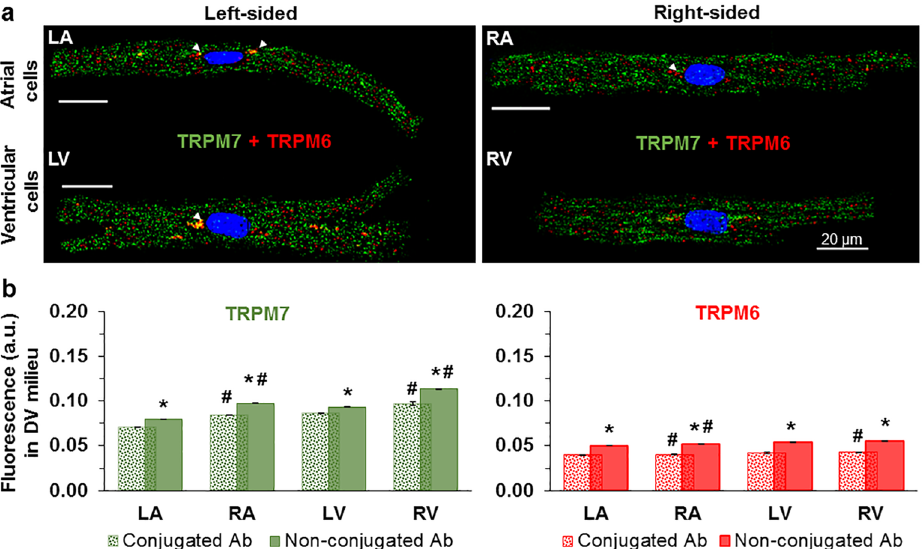
Figure 2. Immunofluorescence images depicting co-expression of TRPM6 and TRPM7 proteins in human cardiomyocytes. ( a ) The immunofluorescence of TRPM7 ( green ) and TRPM6 ( red ) in the same LA, RA, LV, and RV cardiomyocyte when using conjugated antibodies (the arrowheads indicate the localization of TRPM6 protein in perinuclear area). ( b ) Quantification of the staining intensity of the immunodetected conjugated antibodies ( spotty ) and non-conjugated antibodies ( smooth ) for both proteins in cardiomyocytes from the four chambers of the heart as indicated. * P < 0.001 2 h vs. 12 h, # P < 0.001 right-sided vs. left-sided heart chambers. Other notations are the same as in Fig.